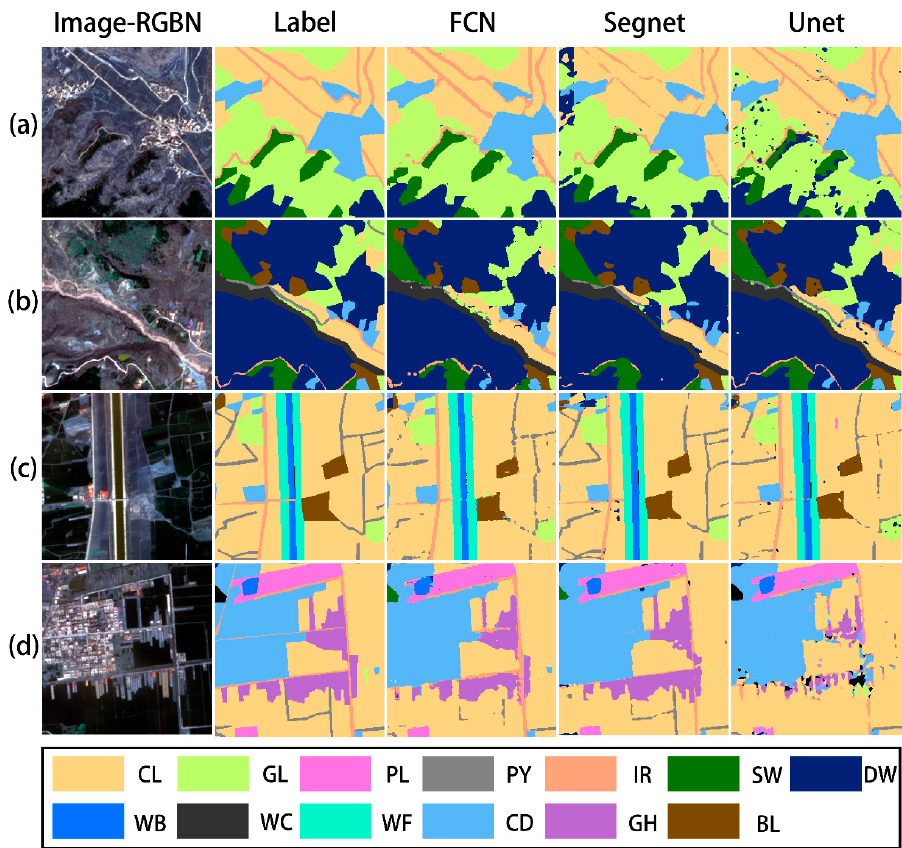
Figure 4. Four typical image subsets ( a – d ) in the study area with different classification results using four bands (R+G+B+ near infrared (NIR)). Columns from left to right represent the original images (R+G+B bands), label map, FCN-8s classification, Segnet classification, and Unet classification, respectively. CL represents cereal land, GL represents grassland, PL represents poplar land, PY represents pathway in farmland, IR represents impervious road, SW represents sparse woods, DW represents dense woods, WB represents water bodies, WC represents a waterless channel, WF represents water conservancy facilities, CD represents construction land, GH represents greenhouse, and BL represents bare land.